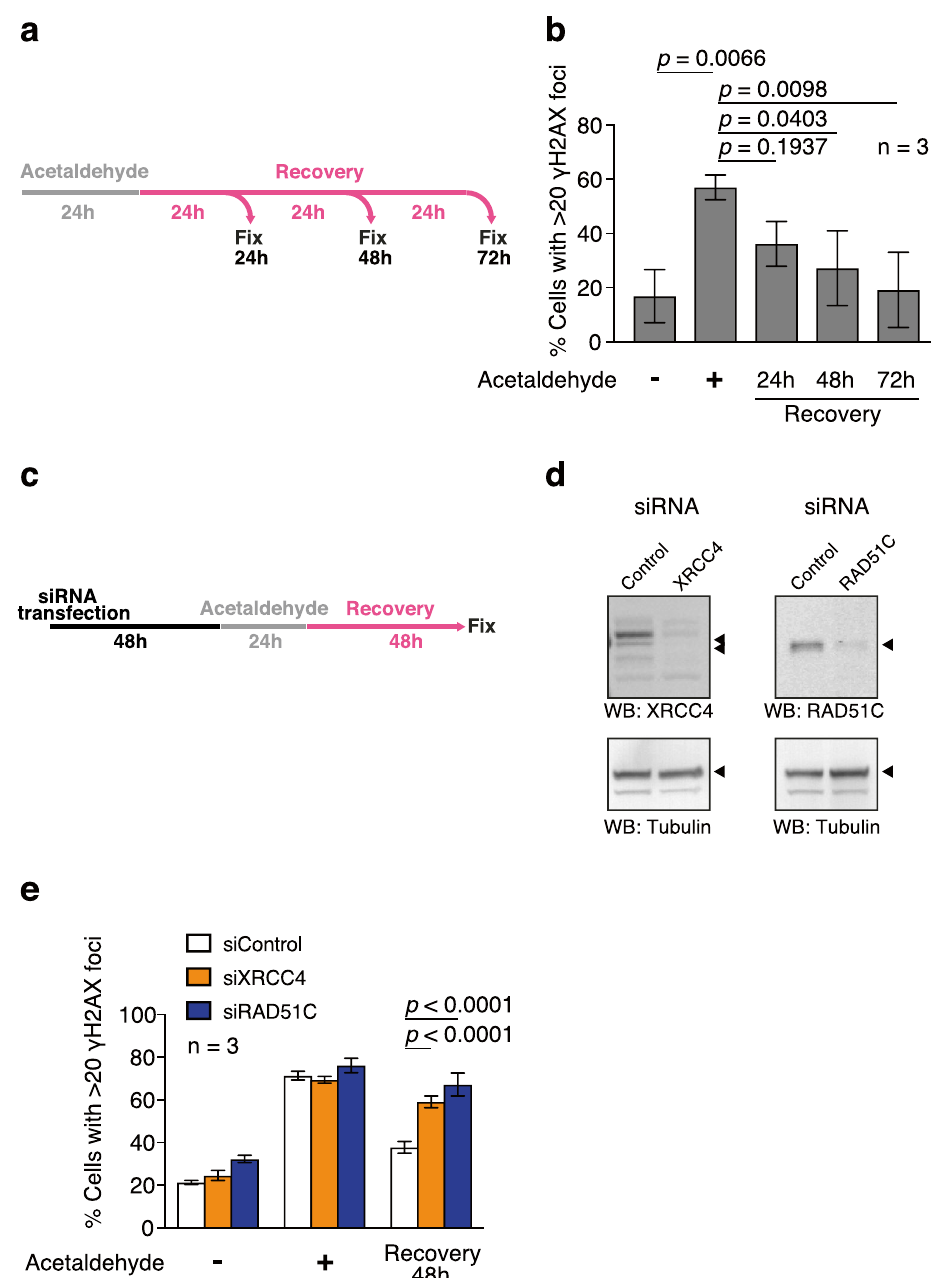
Figure 3. Homologous recombination and non-homologous end-joining are required for repair of acetaldehyde-induced DNA damage. ( a ) Schematic of the DNA repair kinetics experiment. U2OS cells were treated with 10 mM acetaldehyde for 24 h (grey). The cells were washed and incubated in an acetaldehyde- free culture medium (pink). At the indicated time points, cells were fixed and stained with an anti-γH2AX antibody. ( b ) Frequency of γH2AX-positive cells at the indicated time points after acetaldehyde treatment. More than 100 cells were counted in each sample. Statistical significance was determined using unpaired t test. Error bars indicate standard deviation (n = 3). ( c ) Schematic of repair kinetics experiments in RAD51C- or XRCC4-depleted cells. U2OS cells were transfected with siRNA against RAD51C or XRCC4. Forty-eight hours after transfection, the cells were treated with 10 mM acetaldehyde for 24 h. Subsequently, the cells were washed and incubated in acetaldehyde-free medium. Forty-eight hours after release, cells were fixed and stained with an anti-γH2AX antibody. ( d ) Western blotting of whole-cell extracts of XRCC4- or RAD51C-depleted cells to validate the expression of each protein. Tubulin was used as a loading control. ( e ) Frequencies of γH2AX- positive cells in RAD51C- or XRCC4-depleted U2OS cells. More than 100 cells were counted for each condition. Statistical significance was determined using unpaired t test. Error bars indicate standard deviation (n =